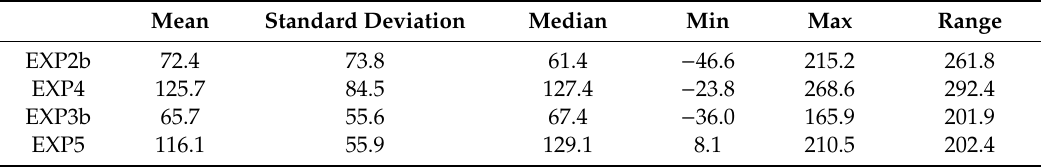
Table 14. RNET (W m − 2 ) simulated by UTOPIA and NOAH, initialized with GLDAS, at the FB station. Mean Standard Deviation Median Min Max